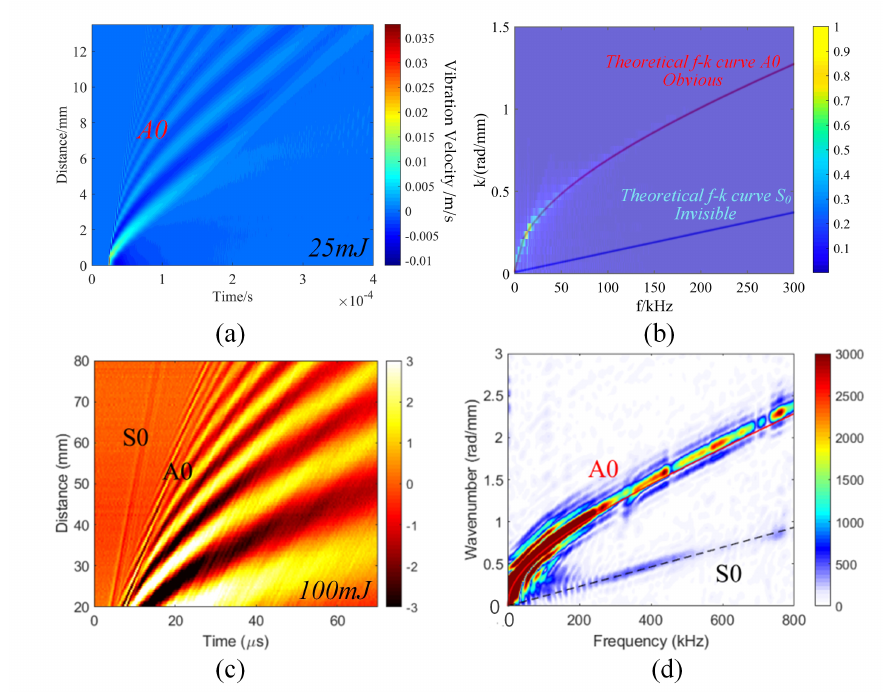
Figure 2. ( a ) Time-space ( t - s ) wavefield and ( b ) frequency-wavenumber domain ( f - k domain) maps of ultrasonic Lamb waves excited by a laser at a single pulse energy of 25 mJ. ( c ) t - s wavefield and ( d ) f - k domain maps of ultrasonic Lamb waves excited by laser at a single pulse energy of 100 mJ [32].